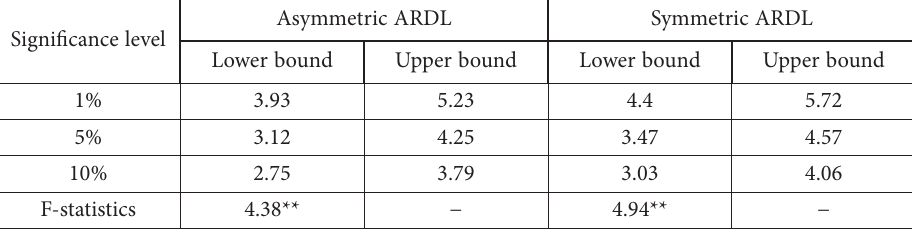
Table 3. Bound cointegration test results